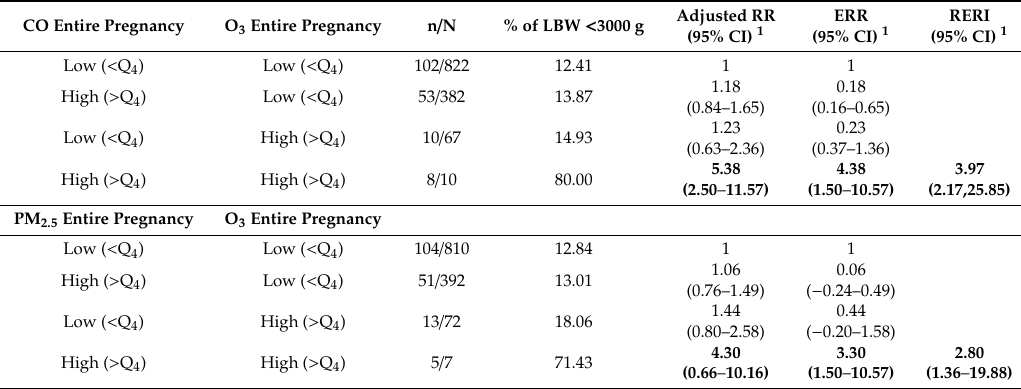
Table 6. Joint e ff ect of CO and O 3, and of PM 2.5 and O 3 exposures during entire pregnancy on low